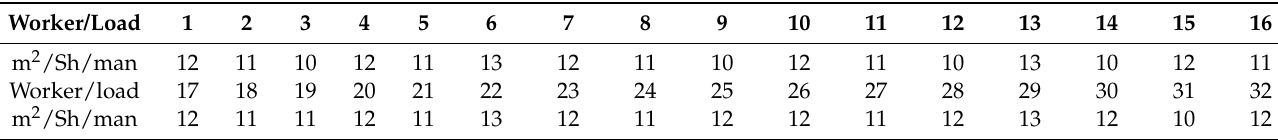
Table 6. Plastering works—performance m 2